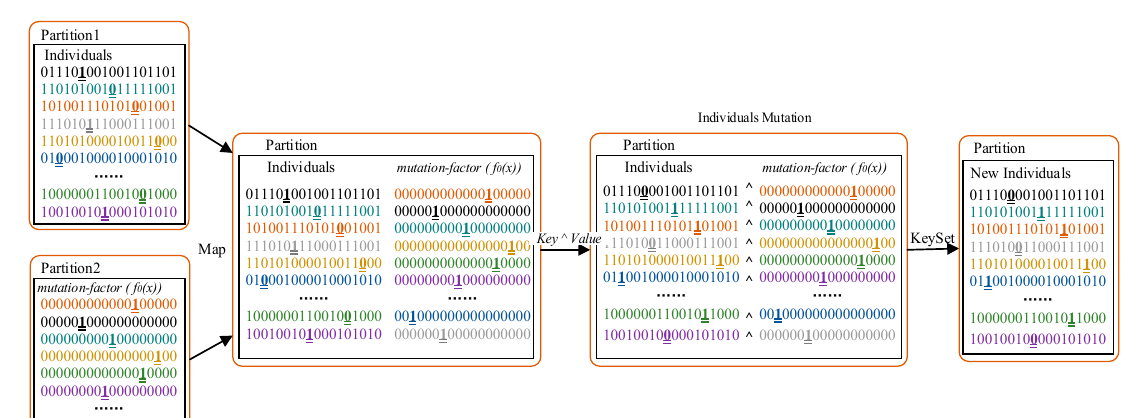
Figure 7. Illustration of crossover.